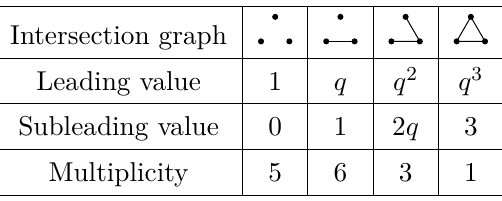
Table 2 . All the intersection graphs for the sixth moment.